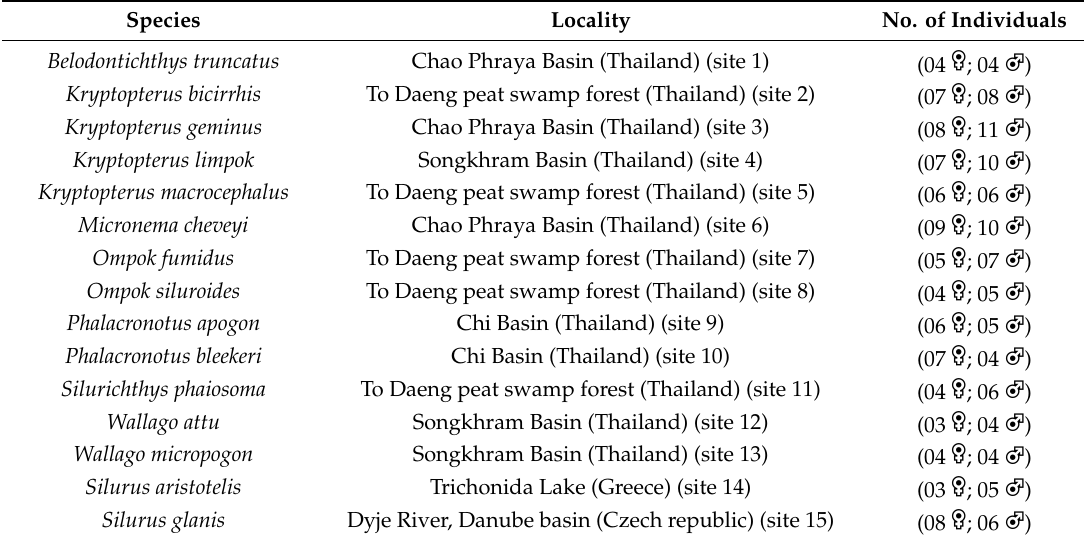
Sites 1 to 15 correspond to the localization of each collection region shown in Figure 7.